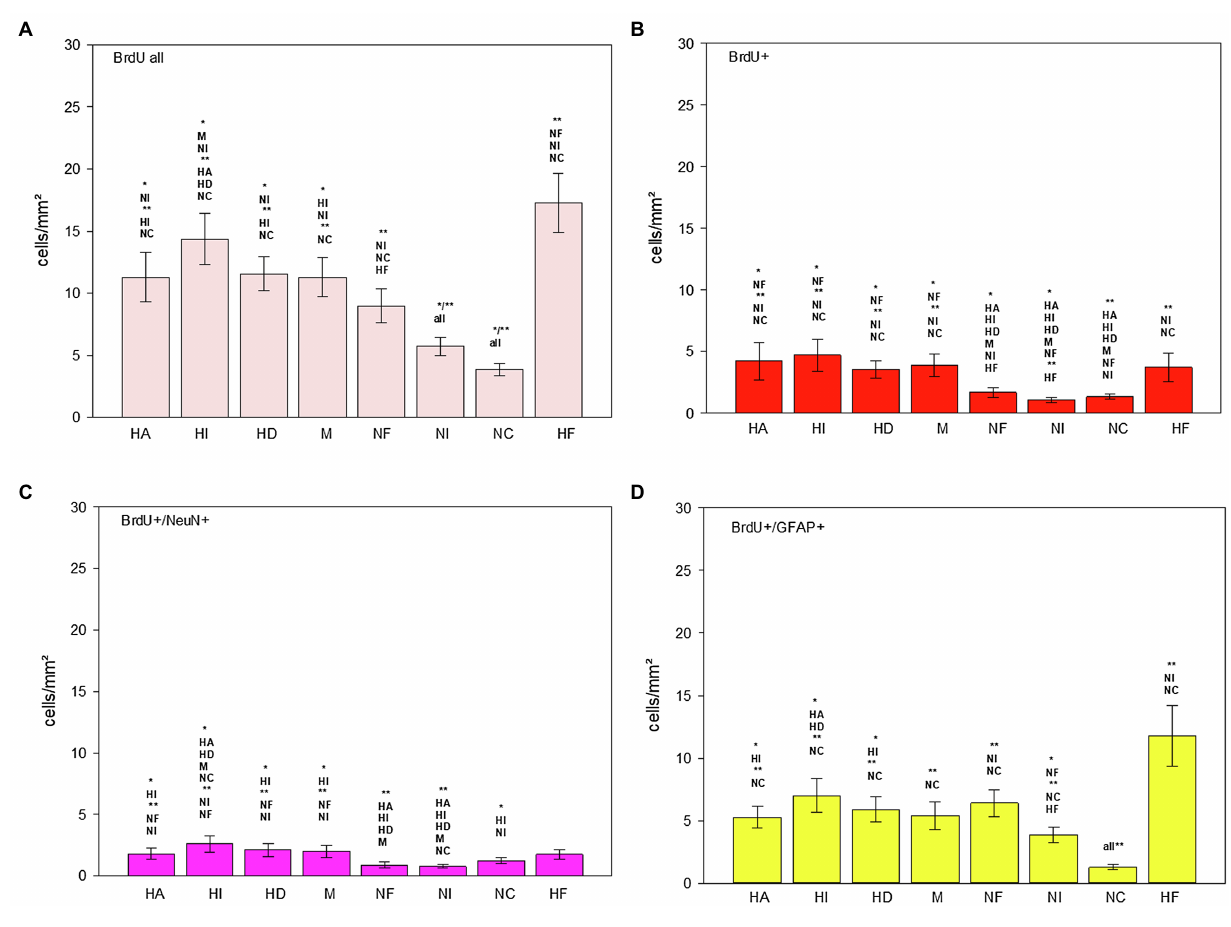
FIGURE 9 | Distribution of BrdU+ (B) , BrdU+/NeuN+ (C) and BrdU+/GFAP+ (D) cells/mm 2 in different regions of the telencephalon of the pigeon ( n = 9). “BrdU all” (A) means the sum of all BrdU labelled cells (single and double labelled). Bars represent mean ± SE. Asterisks indicate significant differences (Wilcoxon Signed Rank Test, * p < 0.05, ** p <